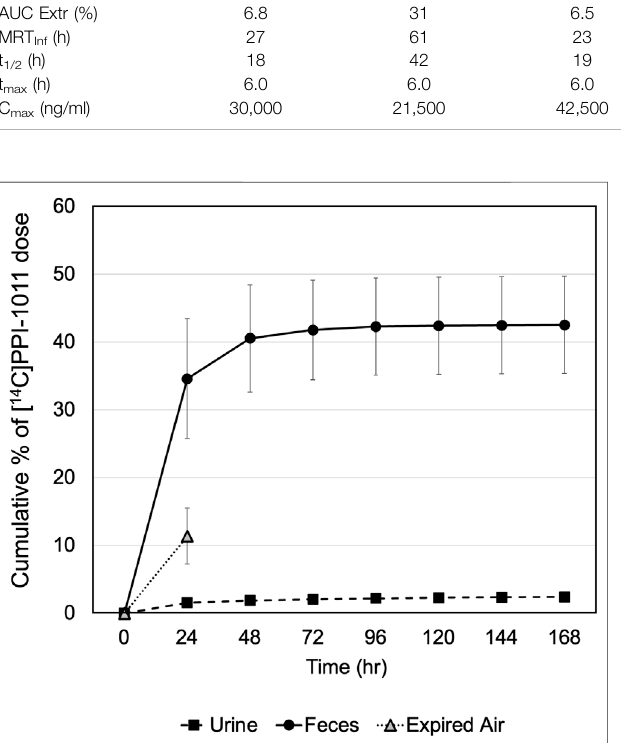
Frontiers in Cell and Developmental Biology |